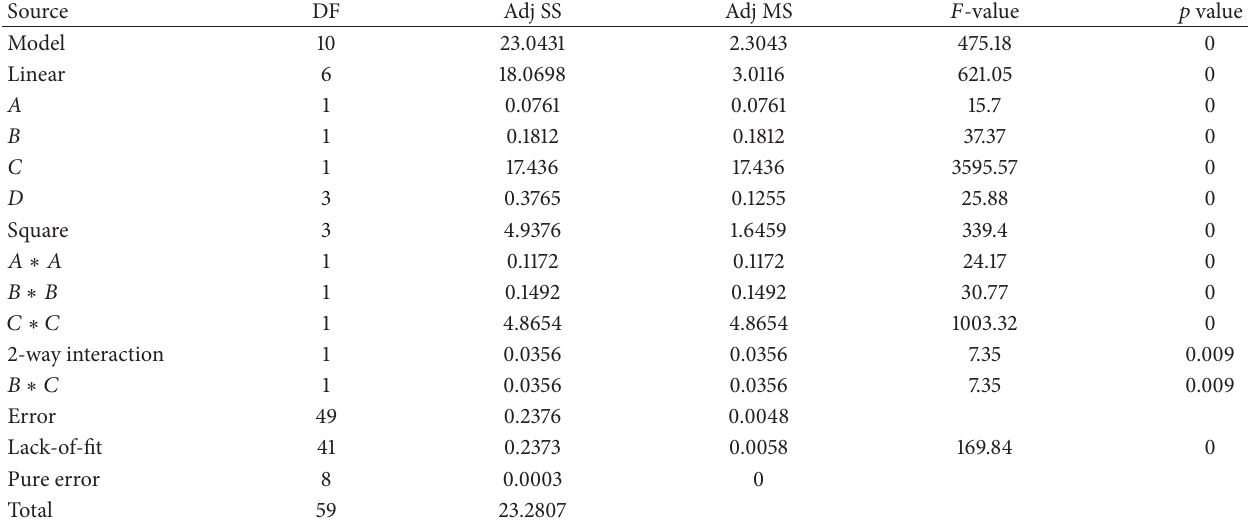
Table 5: ANOVA results for 𝑅 𝑎 .